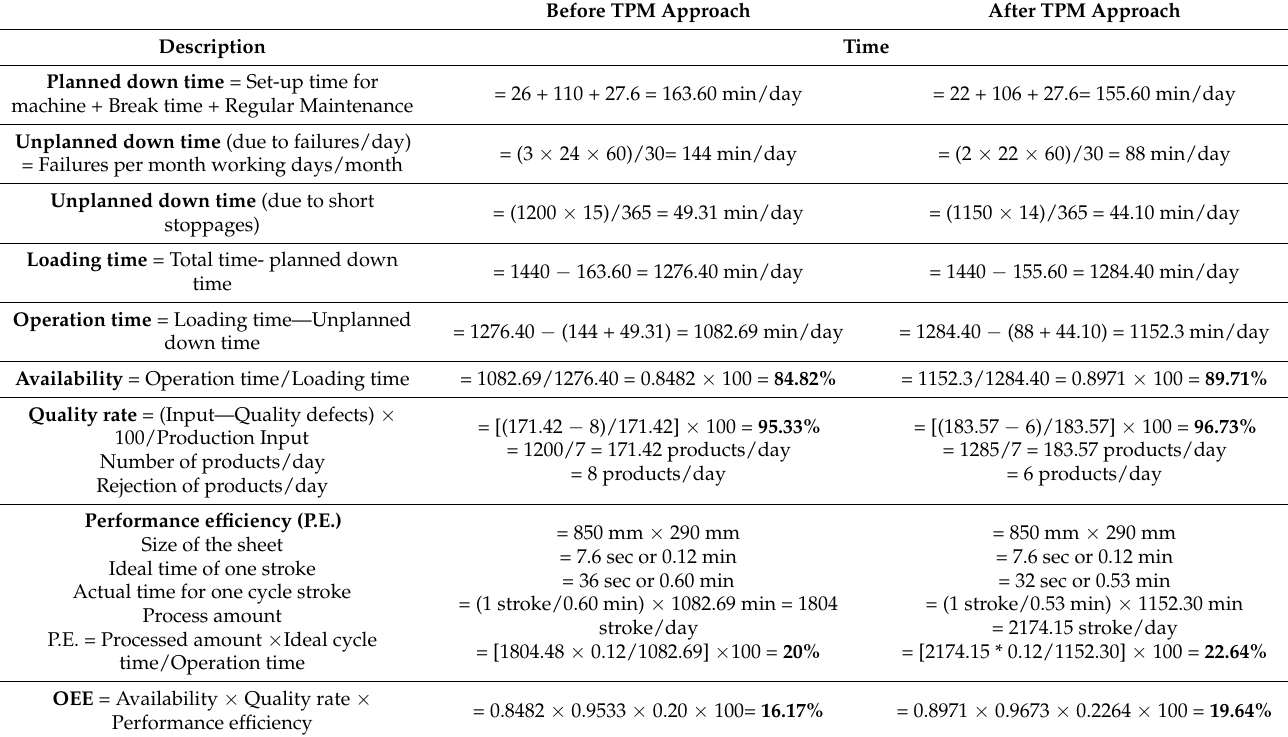
Table 2. Overall equipment efficiency evaluation before/after TPM